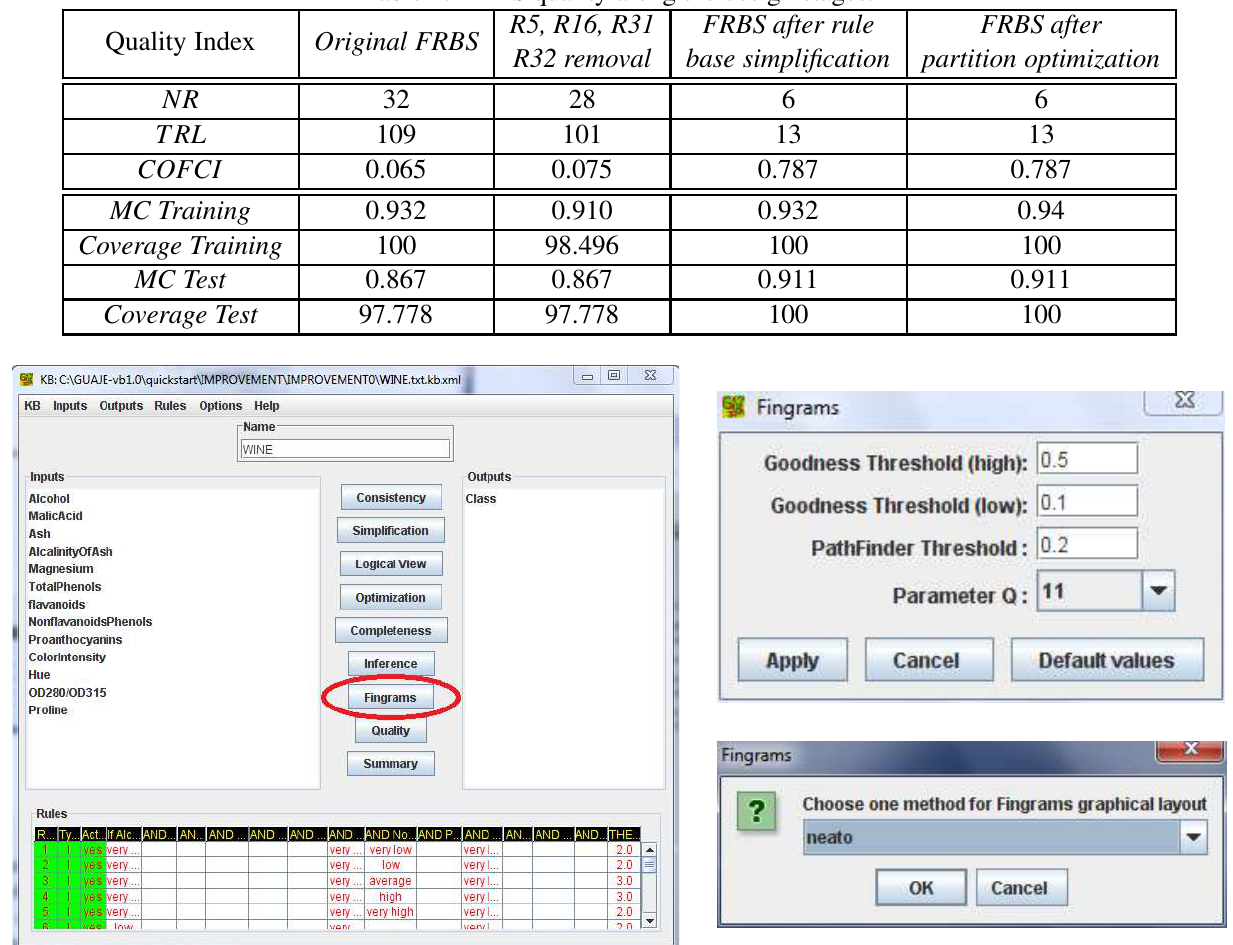
Table 1: FRBS quality along the design stages.